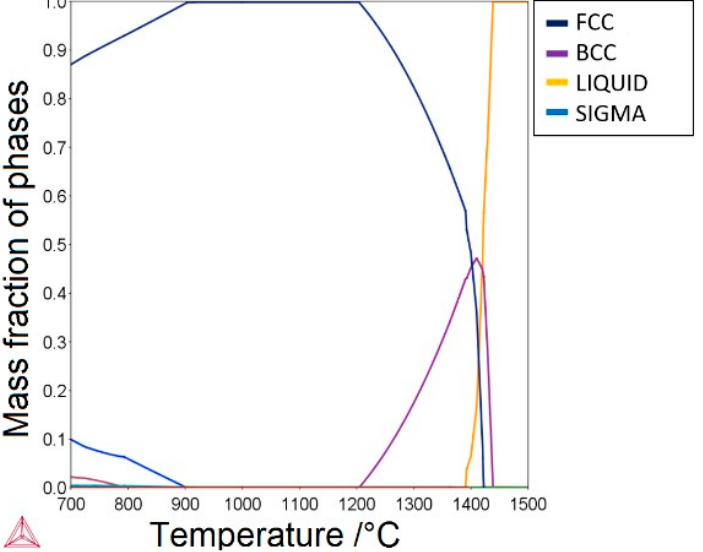
Figure 2. Calculated volume fractions of phases for SS2343 stainless steel depending on the temperature.